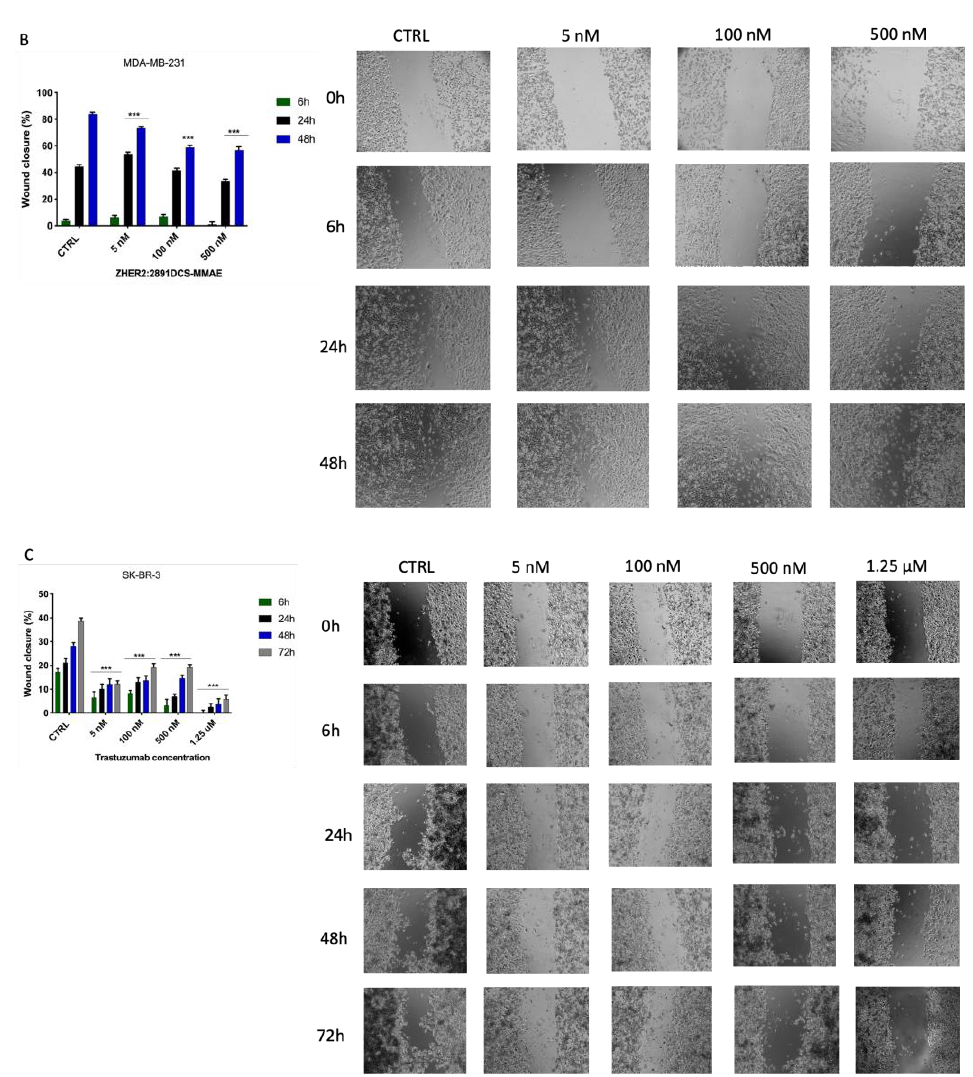
Figure 6. Cell migration assay. The effect on cell migration of Z HER2:2891 DCS-MMAE and trastuzumab, was tested in SK-BR-3 ( A , C ) and MDA-MB-231 cells ( B ) by wound healing assay. Cells were treated with the substances for 6, 24, 48, and 72 h. The p -value was determined by one-way ANOVA test with Dunnett post hoc test and considered significant for p < 0.01 **, p < 0.001 *** compared to control. Data are presented as mean ± SEM.